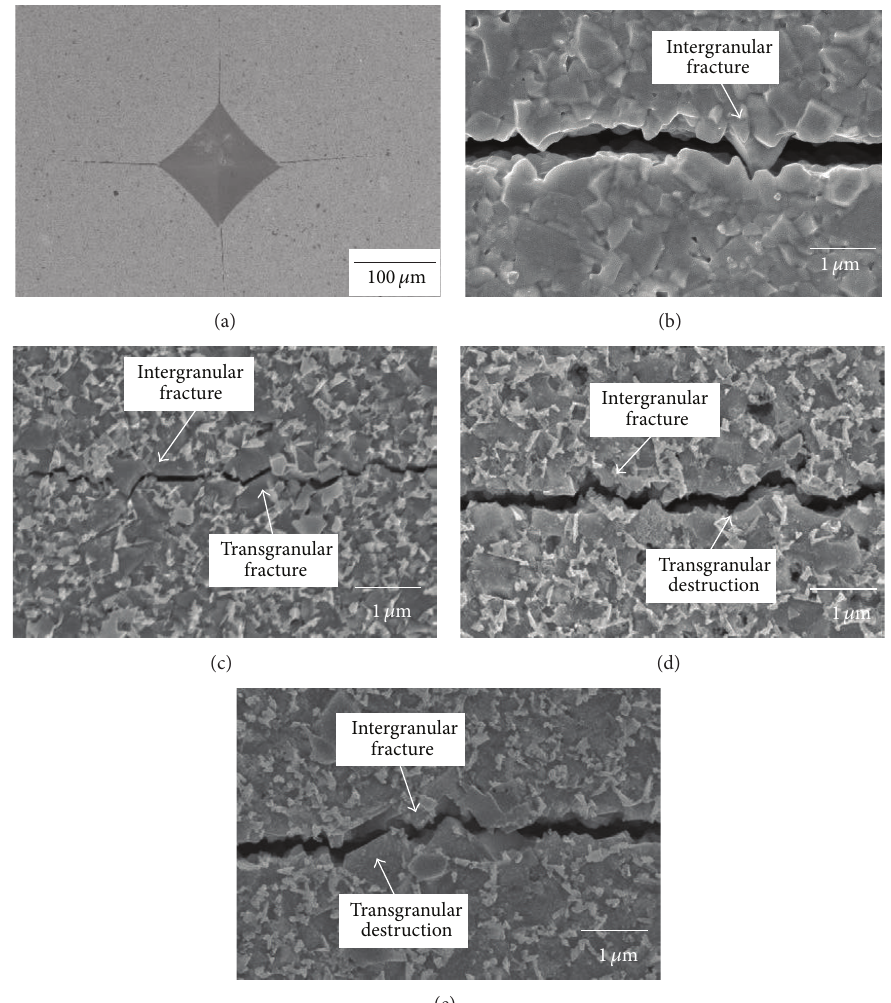
Figure8:Vickershardnessindentation(a)andmediancrackpropagationofsinteredhardmaterials:(b)WC,(c)WC-3wt%Fe,(d)WC-3wt% Ni, and (e) WC-3 wt%